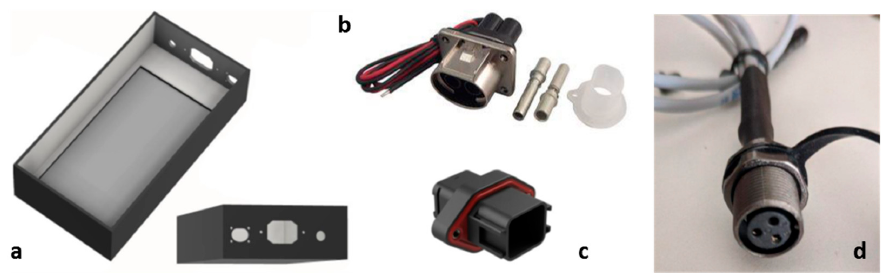
Figure 6. ( a ) Battery pack case; ( b ) rectangular connector for panel mount power supply, 2 contacts; ( c ) connector for BMS: automobilistic, 18 way, female, 13A, IP67 panel mount; ( d ) connector for temperature sensors with panel mount.